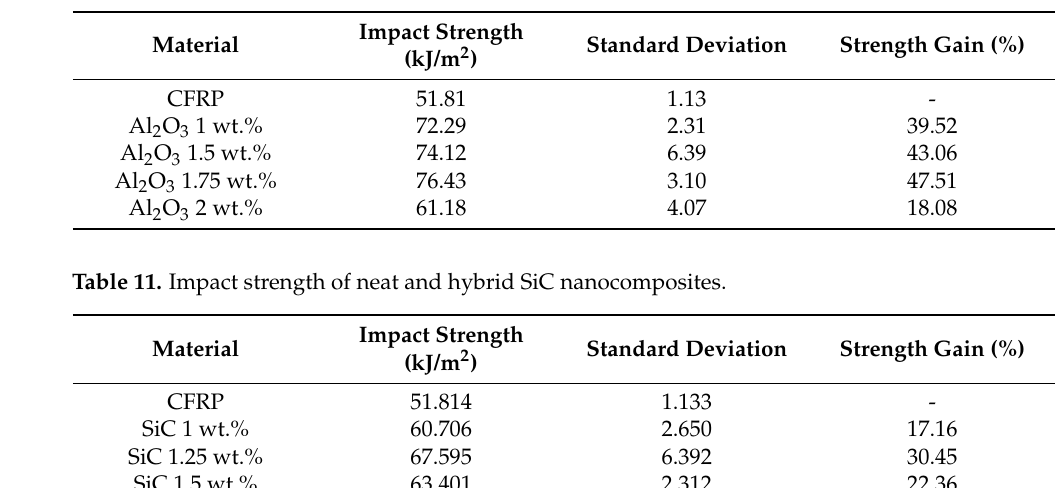
Figure 13. Impact strength of neat and ( a ) hybrid Al 2 O 3 and ( b ) hybrid SiC nanocomposites at various weight fractions. Table 10. Impact strength of neat and hybrid Al 2 O 3 nanocomposites.